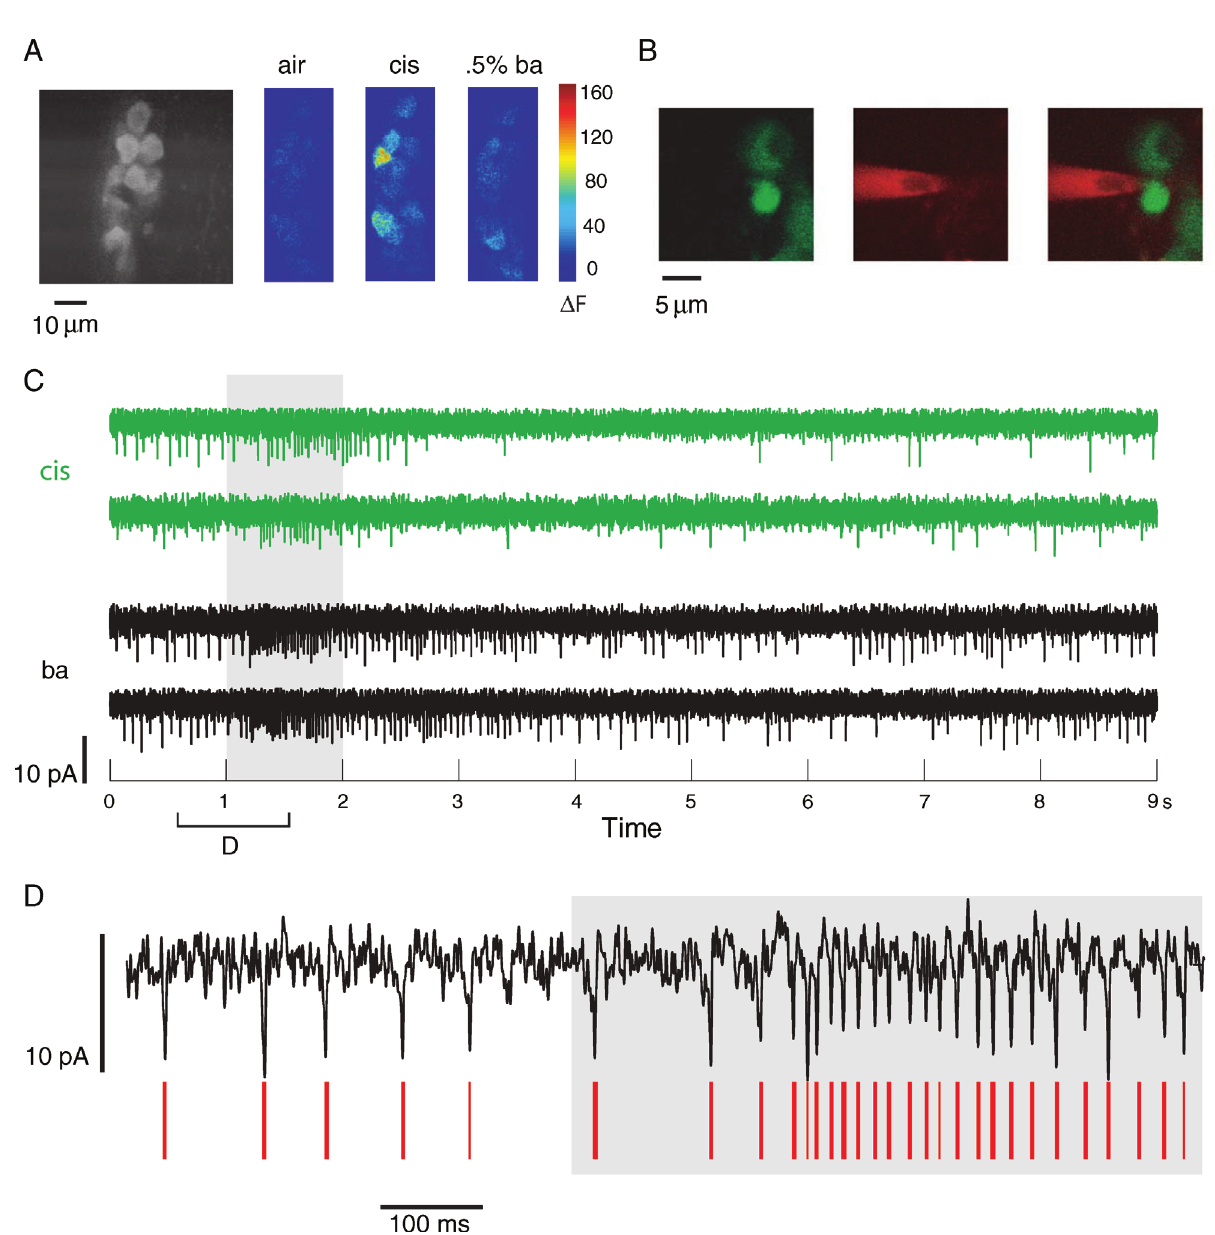
Figure 1. Loose-patch recording from identified PNs in GH146-Gal4, UAS-GCaMP flies . ( A ) Baseline levels of fluorescence (left) of G-CaMP-expressing dorsal PNs, and absolute changes in (8-bit) fluorescence intensity levels in response to air and two odor presentations. ( B ) Two-channel imaging showing (from left) images in the green, and red channels; image on right is an image created from merging the two channels. Images verify that cell was not broken into during recording. ( C ) Current traces from the PN above. Shown are responses to two different odor presentations (two trials each) (gray bar). ( D ) Spikes, although small, can be separated from the noise by a combination of amplitude and fast deflection (see Materials and Methods). Red lines indicate spikes detected